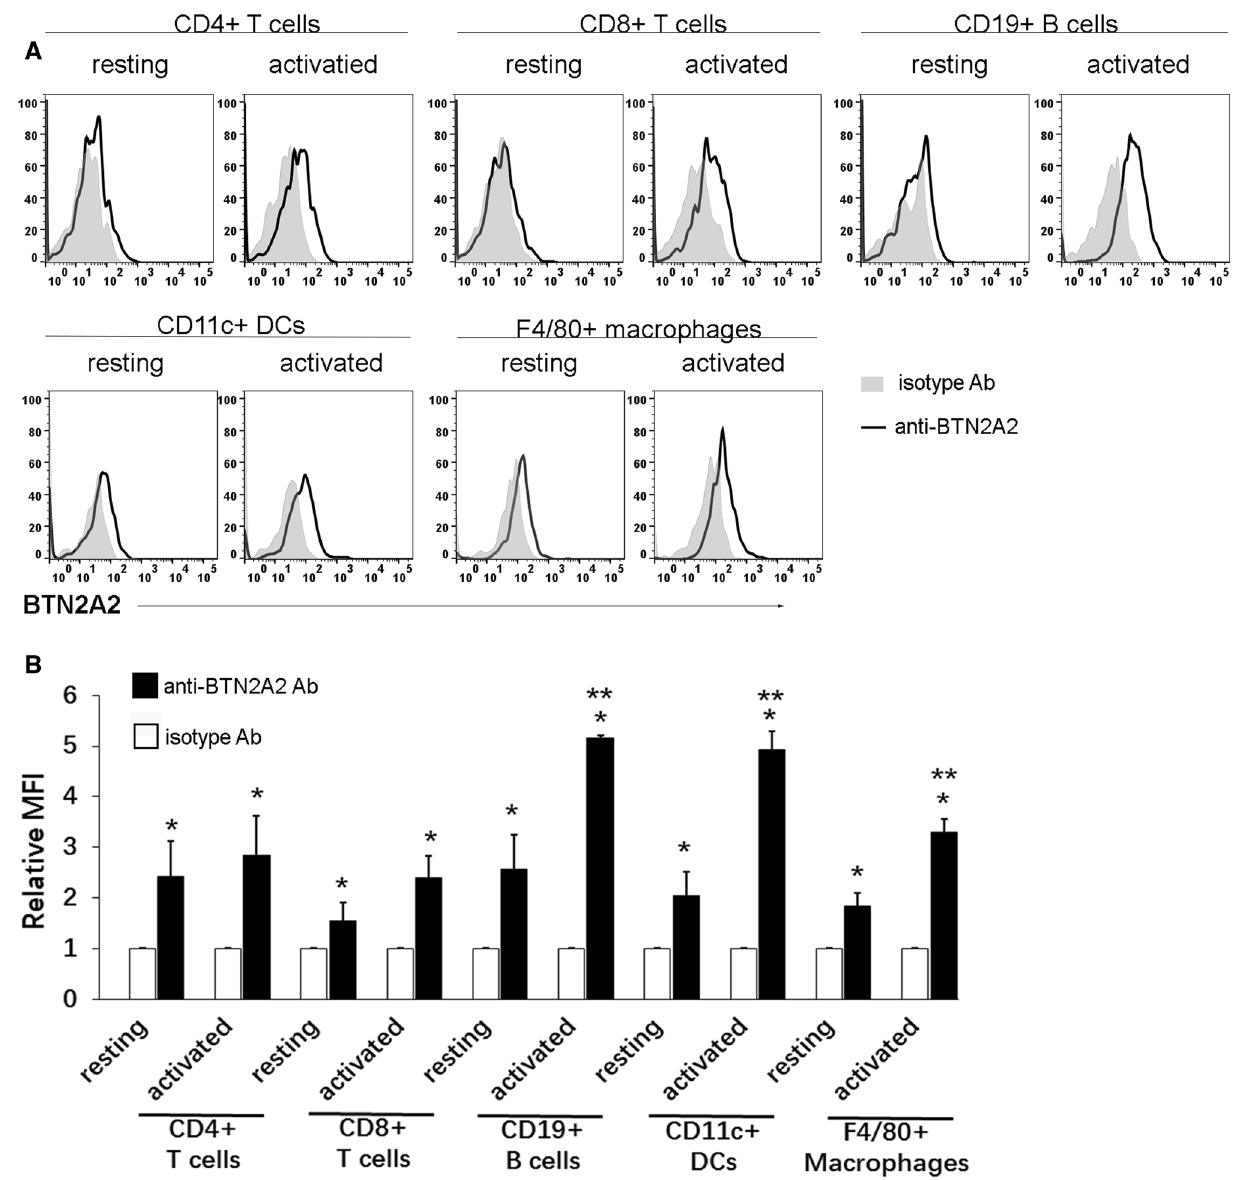
Figure 1. The expression pattern of BTN2A2 protein on immune cells. ( A ) Splenocytes from C57BL/6 mice that were freshly harvested were used for resting immune cells. To activate T cell, splenocytes were incubated with anti-CD3 antibody (1 μg/ml) for 3 days. To activate B cells, DCs, monocytes and macrophages, splenocytes were stimulated with LPS (5 μg/ml) for 3 days. The resting and activated immune cells were stained with anti- BTN2A2 or isotype antibody as well as anti-CD4, CD8, CD19, CD11c or F4/80 antibody to identify immune cells. The cells were analyzed for BTN2A2 protein expression by flow cytometry. Representative flow cytometric profiles, and ( B ) Statistical analysis for the expression levels BTN2A2 on immune cells. Data are presented as relative fluorescence intensity (RFI) for the cells stained with antiBTN2A2 antibody versus cells stained with isotype antibody. *P < 0.05 compared with isotype antibody. **P < 0.05 compared with resting cells. The data are representative of three independent experiments with similar results (n = 3 each